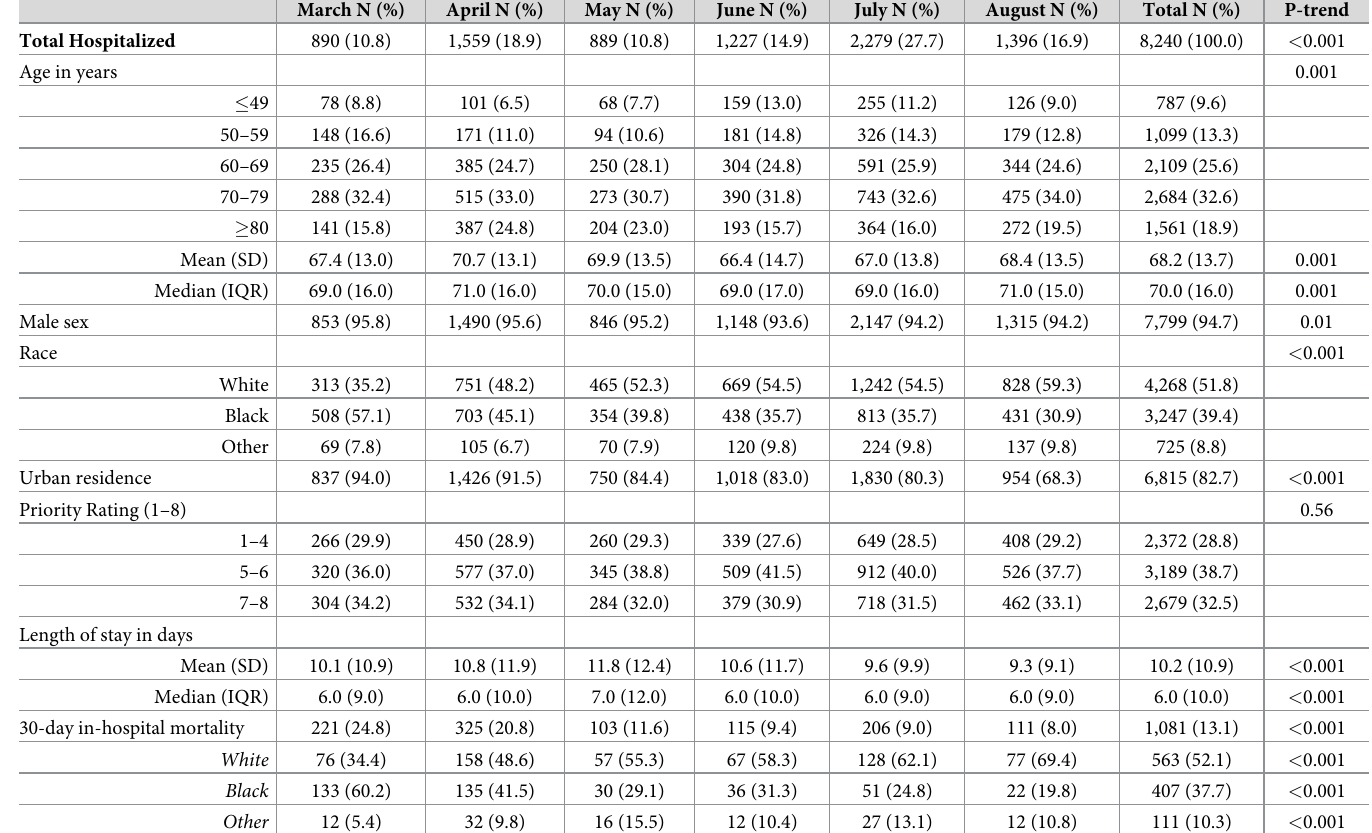
Table 1. Patient characteristics � among 8,240 hospitalized Veterans Health Administration users with coronavirus disease 2019 (COVID-19), March 1, 2020 – August 31,